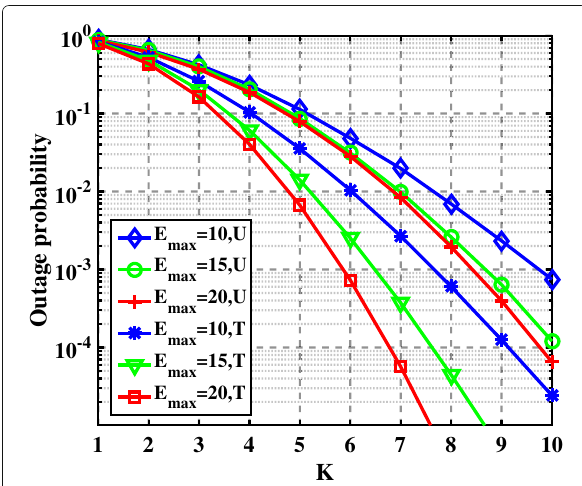
Fig. 8 Outage probability vs. th with different noise variance